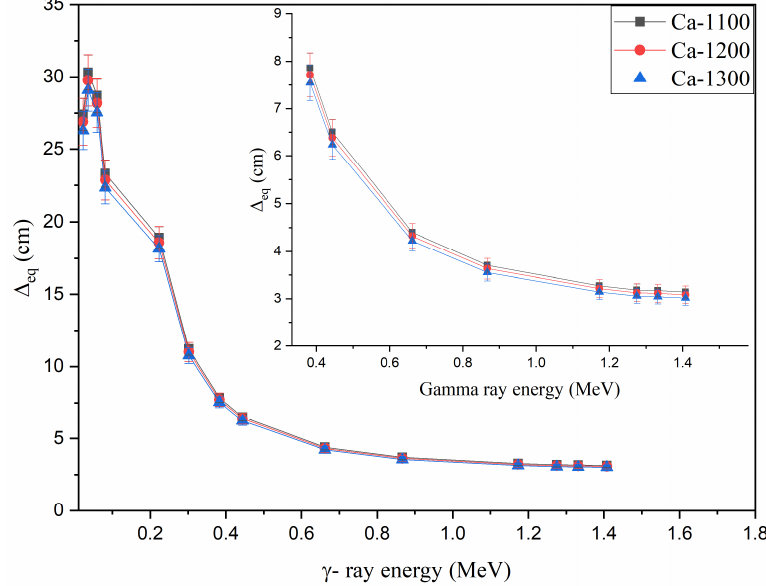
Figure 6. Dependence of the equivalent thickness on the incident γ-ray photons.